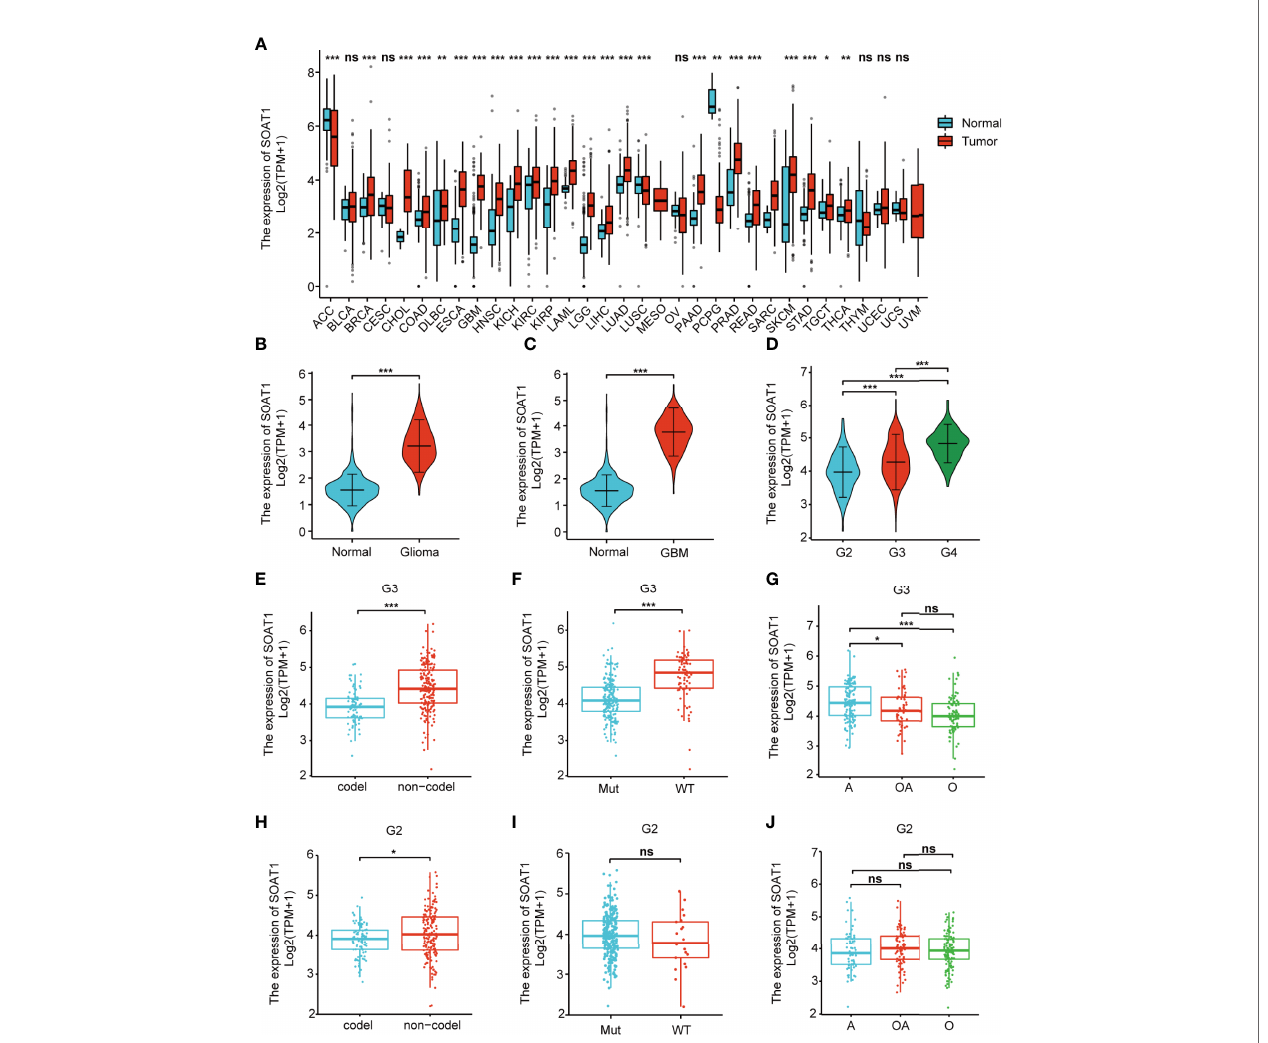
FIGURE 1 | SOAT1 mRNA was overexpressed in various tumors, including glioma, and the high SOAT1 expression predicted an advanced malignancy of glioma. (A) Pan-cancer analysis was performed to compare the mRNA level of SOAT1 between tumors and corresponding normal tissues in the integrated datasets (combined TCGA with GTEx databases). (B) Expression levels of SOAT1 in overall glioma and normal tissues from the TCGA and GTEx databases. (C) Expression levels of SOAT1 in GBM and normal tissues from the TCGA and GTEx databases. (D) Expression levels of SOAT1 in different tumor grades from the TCGA dataset. (E – J) Expression levels of SOAT1 in 1p19q non-co-deleted and 1p19q -co-deleted types, IDH wild and IDH mutant types, astrocytoma, and oligodendroglioma and oligoastrocytoma in grade 2/3 gliomas from TCGA dataset. G2, WHO grade 2; G3, WHO grade 3; G4, WHO grade 4; codel, 1p19q -co-deleted type; non-codel, 1p19q non-co-deleted type; Mut, IDH mutant type; WT, IDH wild type. A, astrocytoma; OA, oligoastrocytoma; O, oligodendroglioma; SOAT1 , sterol O-acyltransferase 1 ; GTEx, genotype-tissue expression; TCGA, The Cancer Genome Atlas; IDH, isocitrate dehydrogenase. ns, P ≥ 0.05; *P < 0.05; **P < 0.01; ***P <